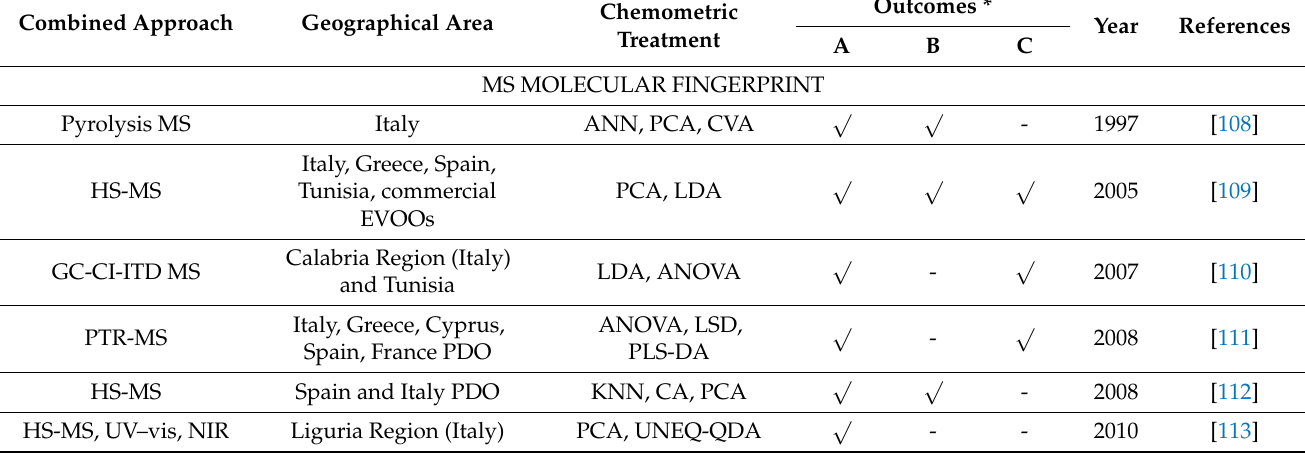
Table 4. Geographical classification studies of EVOOs by MS, according to the chronological order of